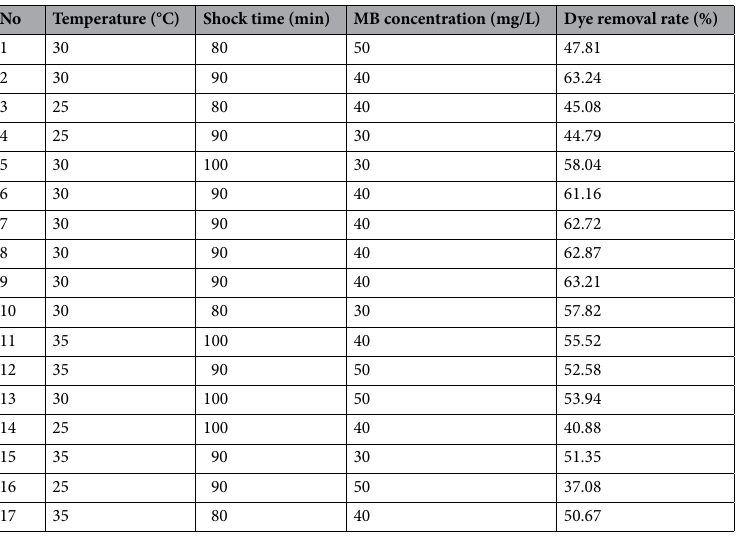
Table 2. Box-Behnken Design Test Results.